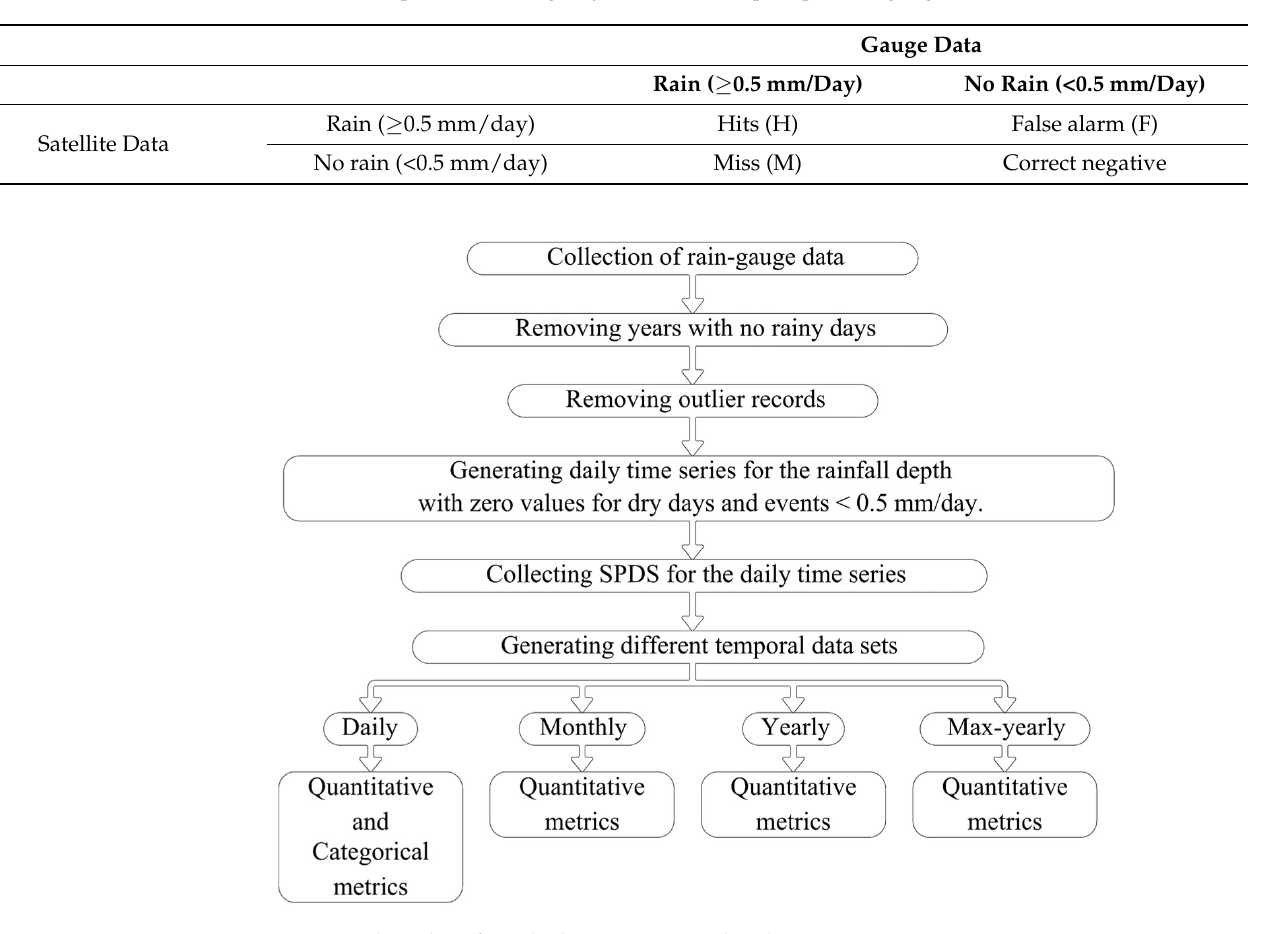
Figure 4. Flow chart for calculating categorical and quantitative metrics.